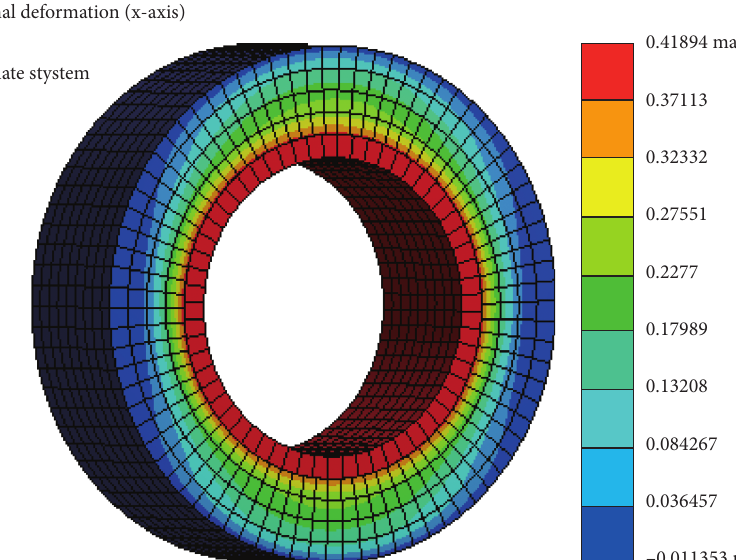
Figure 12: Displacement cloud diagram of shaft damping ring.